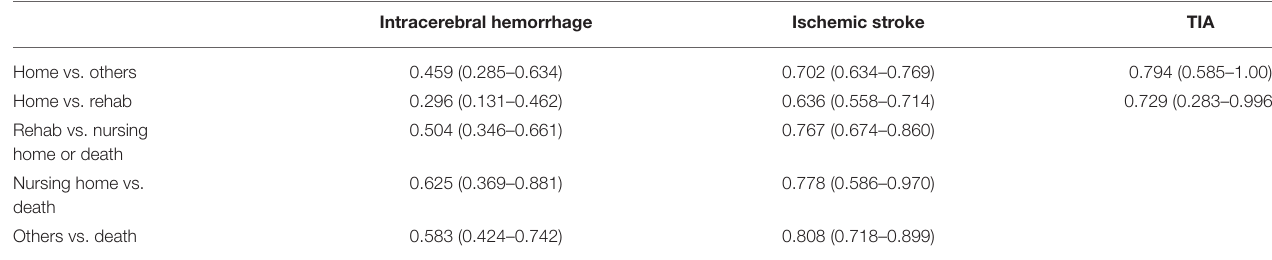
TABLE 5 | AUC of prediction for three different sub-cohorts of stroke at five different settings. Intracerebral hemorrhage Ischemic stroke TIA Home vs. others